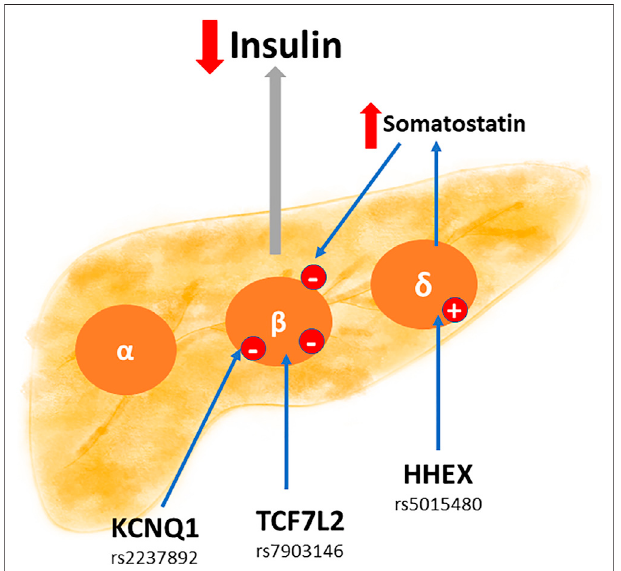
FIGURE 2 | Potential SNPs capable of reducing the production of maternal insulin at a pancreatic level. Some SNPs can affect the secreting function of pancreatic insulin. In this sense, the SNPs KCNQ1 rs2237892, TCF7L2 rs7903146 and HHEX rs5015480, reduce (down red arrow) direct or indirectly the production and secretion of insulin at the level of the beta cells ( β ). Moreover, the same HHEX SNP can stimulate (up red arrow) somatostatin secretion in delta cells ( δ ), and this hormone is an inhibitor of insulin secretion. Impaired insulin production favors insulin resistance, and therefore the appearance of gestational diabetes mellitus.